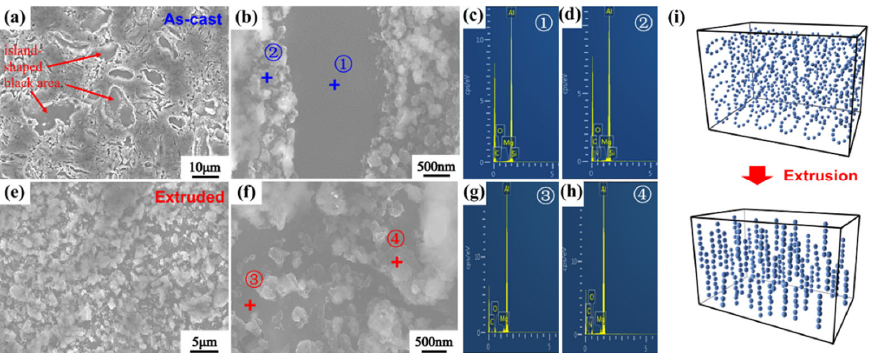
Figure 6. SEM images of nano-AlN/Al composites after electrolytic etching: ( a , b ) As-cast; ( e , f ) After HE. ( c , d , g , h ) are the energy spectrum of points 1, 2, 3, and 4. ( i ) is the schematic diagram of distribution of AlN particles before and after HE.